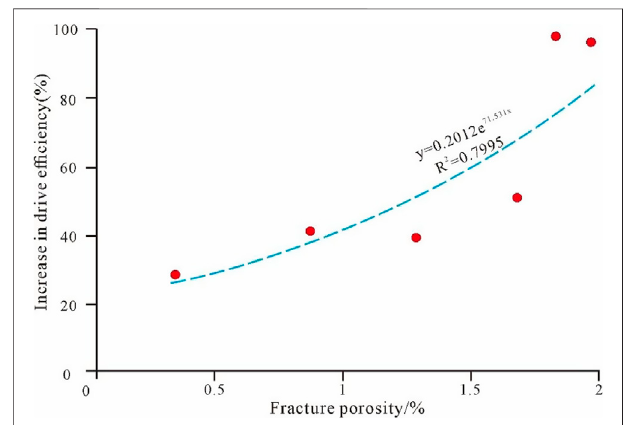
FIGURE 13 | Scatter plot of porosity interpreted by NMR and ef fi ciency of gas drive. FIGURE 14 | Relationship of increase in the ef fi ciency of gas drive and